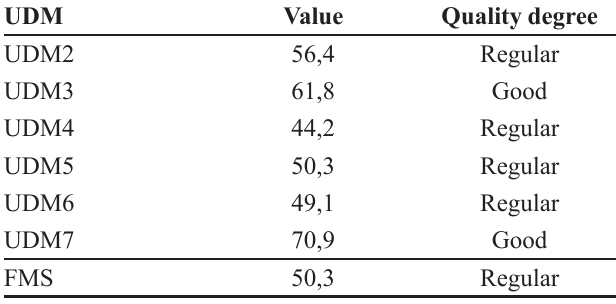
TABLE IV - Quality degree of the pharmaceutical services in HIV/AIDS in the Health Foundation of Niterói city